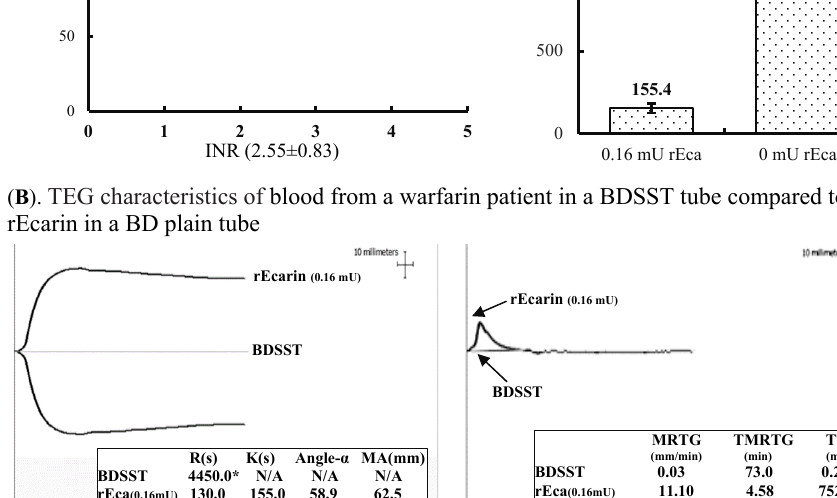
Figure 4. rEcarin effectively clots blood from patients on warfarin therapy. ( A ) rEcarin efficiently clots recalcified citrated whole blood samples from 15 patients being treated with warfarin at 1.3–4.2 of international normalized ratio (INR) (an average of INR at 2.55 ± 0.83). Left panel : rEcarin (0.16 mU/4 mL blood) effectively clotted the warfarinized bloods from 15 patients ranging from 112 to 227 s. Right panel : The average clotting time of blood from 15 patients by rEcarin (0.16 mU). The warfarinized blood did not clot at 3000 s without the addition of rEcarin. ( B ). The thromboe- lastography (TEG) assay shows TEG images of one warfarin patient’s blood in a BDSST tube and a BD plain tube containing 0.16 mU of rEcarin, revealing significantly different thromboelastographic traces of the same recalcified blood and four TEG parameters (R times, K time, angle- α and MA value) shown in inserted squares ( Left hand panel ), and the different V curves and three thrombin generation parameters (MRTG, TMRTG and TG) shown in the inserted squares ( Right hand panel